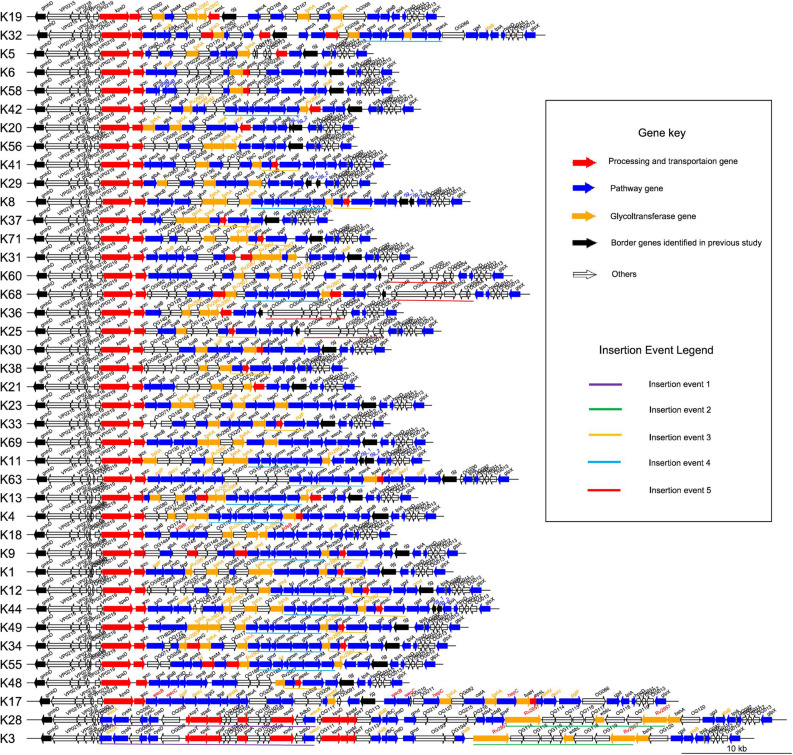
Genetic structure of 40 K-serogroup CPSgcs. Each line represents a gene cluster, and one arrow refers to one gene; the direction of arrow refers to the direction of genes. There are four filling colors of arrows representing four gene function classes: red refers to processing and transportation genes, blue refers to pathway genes, orange refers to glycotransferase genes, transparent refers to others (gene function unknown or cannot be classified), and black refers to two border genes gmhD and rjg identified in a previous study (Chen et al., 2010). In addition, gene names are in black font as default, whereas gene names in red font represent multi-copies originated by gene self-duplication; those in blue font represent multi-copies originated by nonsense mutation, and those in orange font represent multi-copies originated by recombination in corresponding K-serogroup. Underlines of five different colors highlight five insertion recombination events. K-serogroups were classified, ordered, and colored according to Figure 4 (red: group 1, green: group 2, orange: group 3, blue: group 4, purple: group 5).